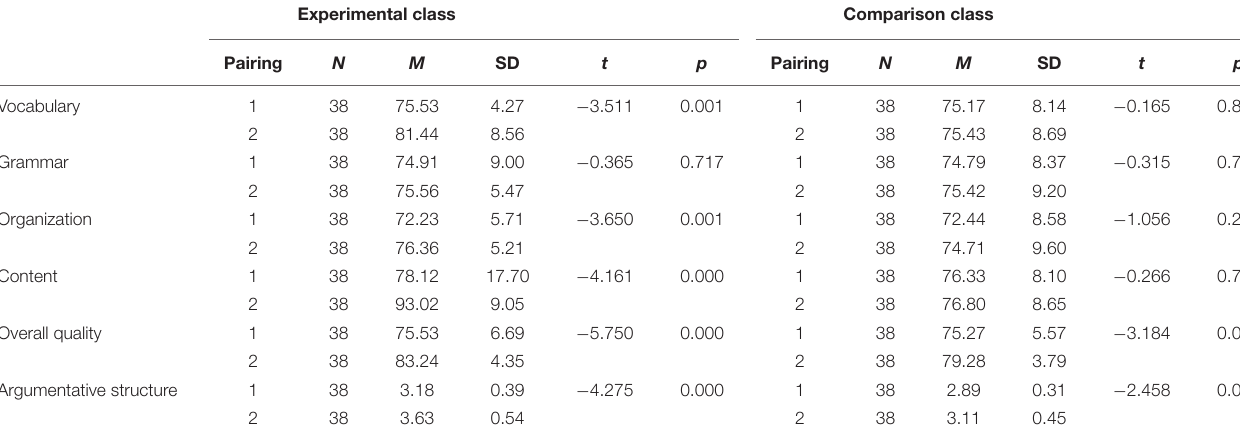
TABLE 2 | Descriptive and paired-samples t -test results of the two classes’ essay performance.